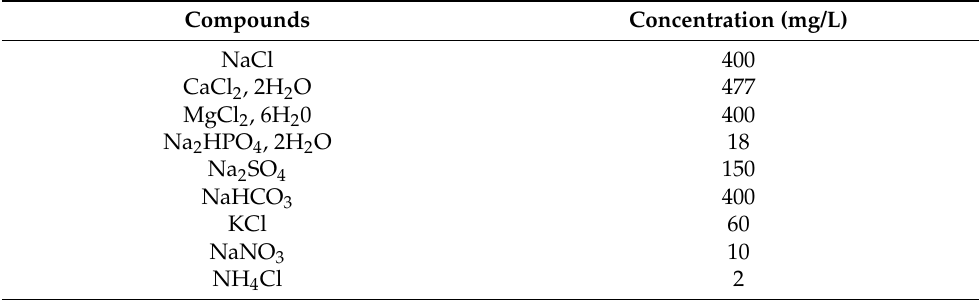
Table 3. Salts used to prepare the synthetic ionic